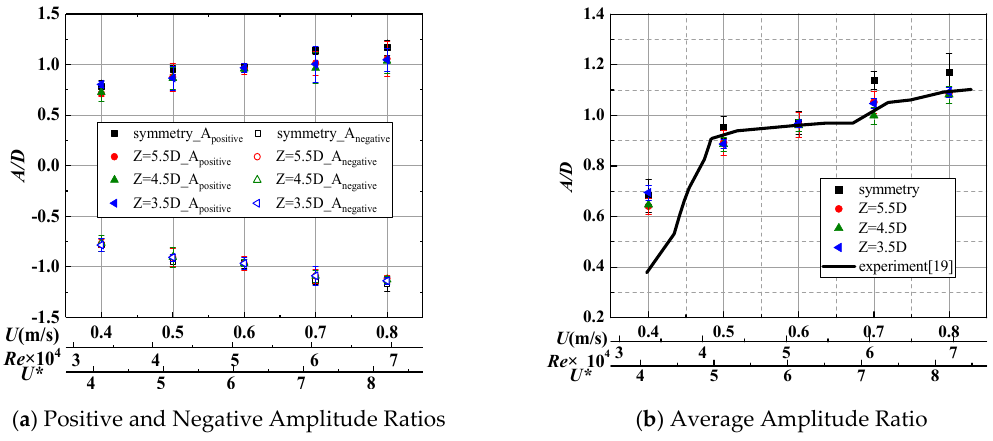
Figure 14. The amplitude ratios ( A / D ) of the PTC cylinder flow-induced vibration in the free surface flow.